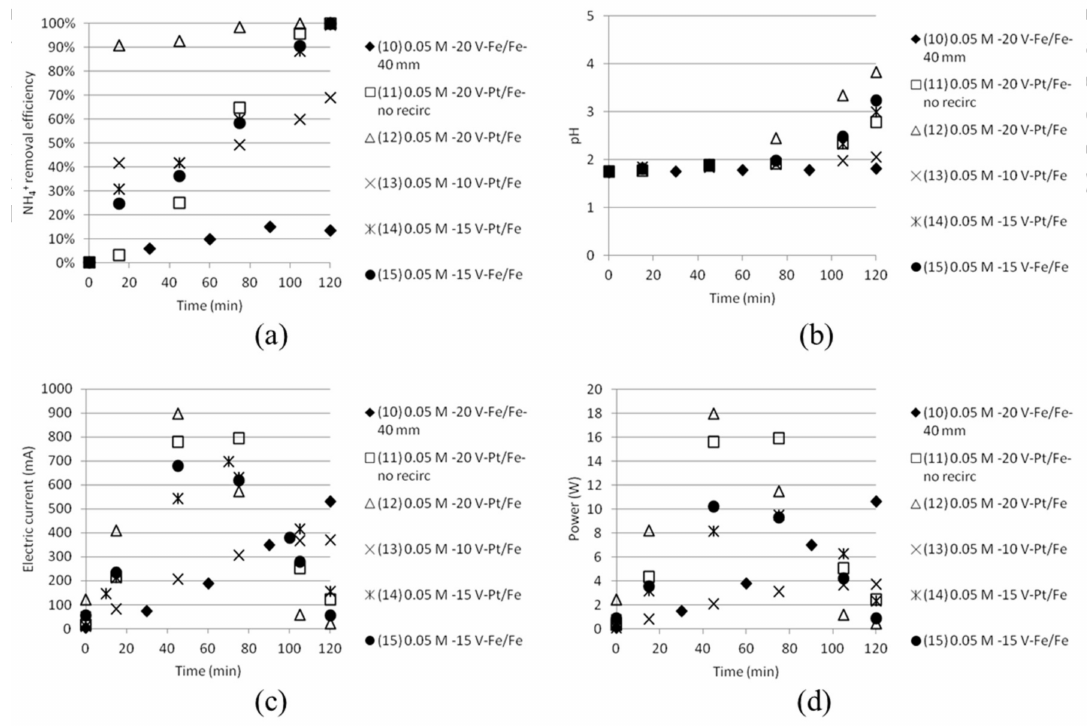
Figure 10. ( a ) NH 4 + removal efficiency; ( b ) pH; ( c ) electric current and ( d ) power as function of time for tests done with five